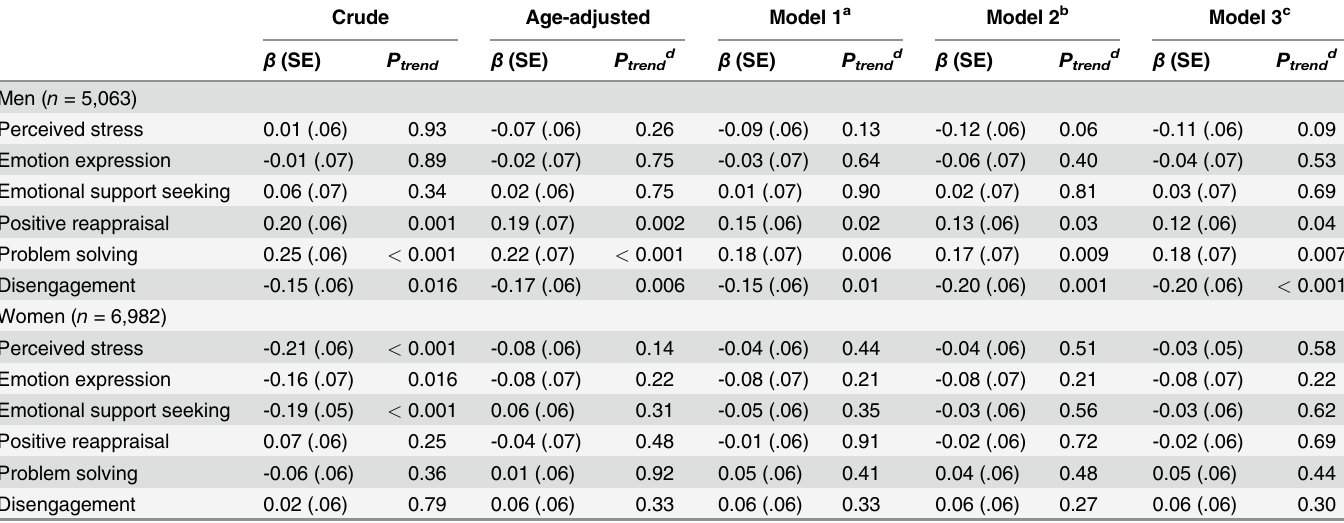
Table 3. Regression analyses for the associations of perceived stress and coping strategies with body mass index by gender — Japan, 2005 –